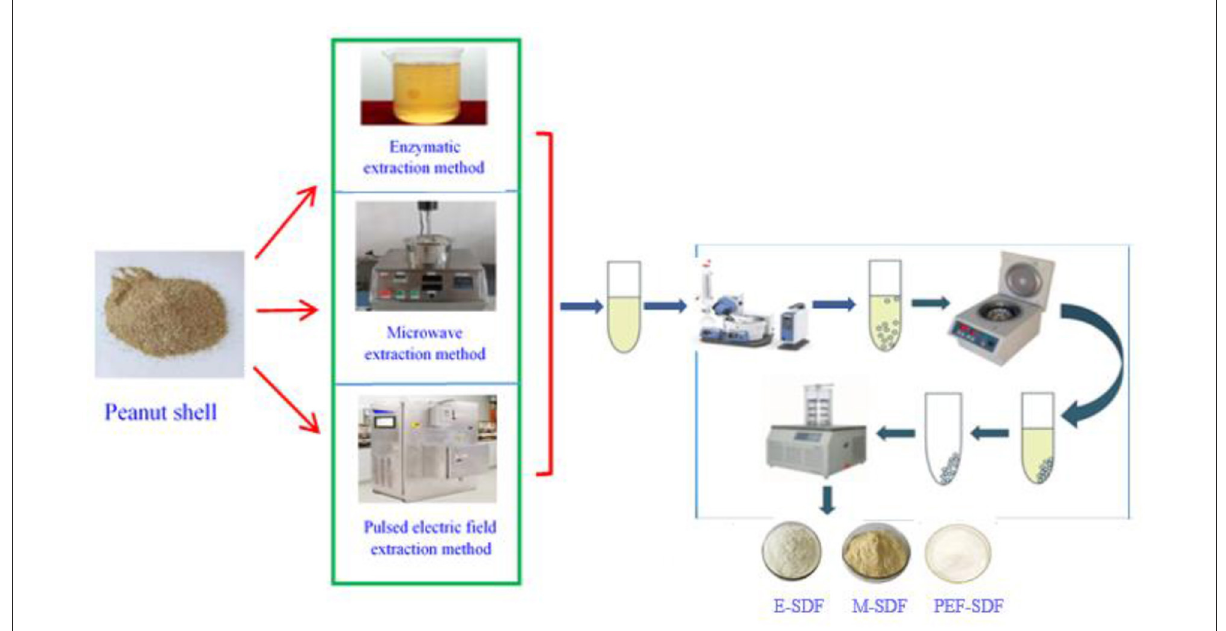
FIGURE1 A scheme of soluble dietary fiber (SDF) extraction procedure.